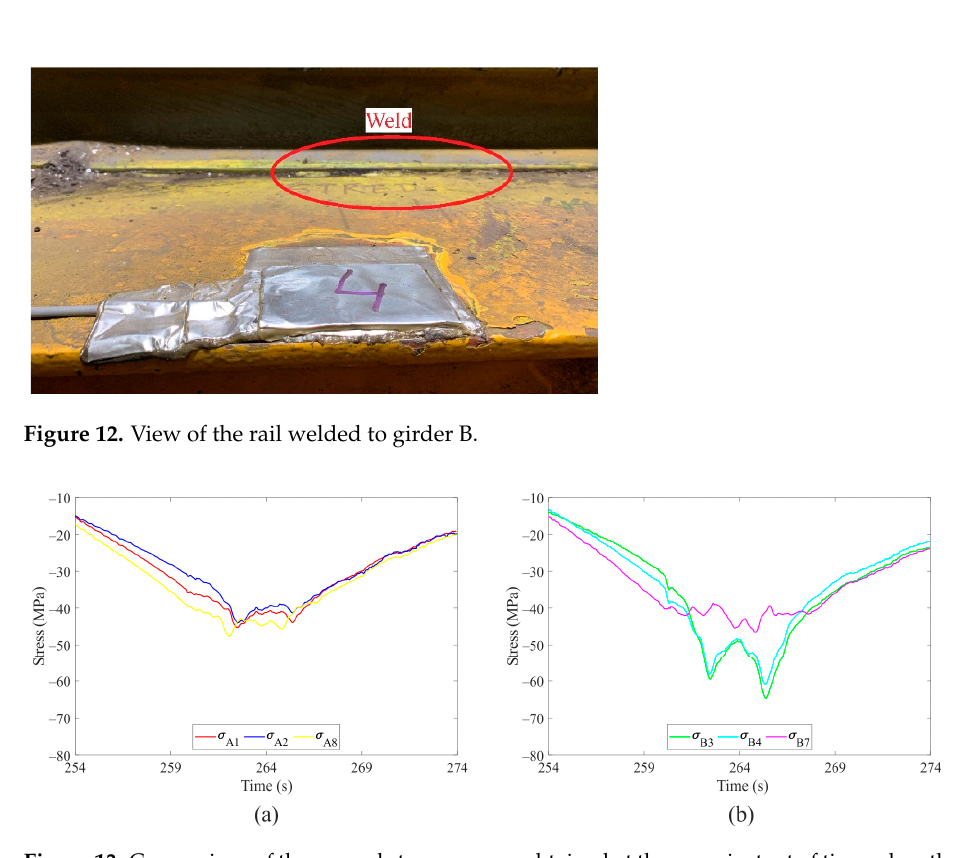
Figure 13. Comparison of the normal stress courses obtained at the same instant of time when the crab passed through the center of the girders: ( a ) girder A (locations 1, 2, 8), ( b ) girder B (locations 3, 4, 7).